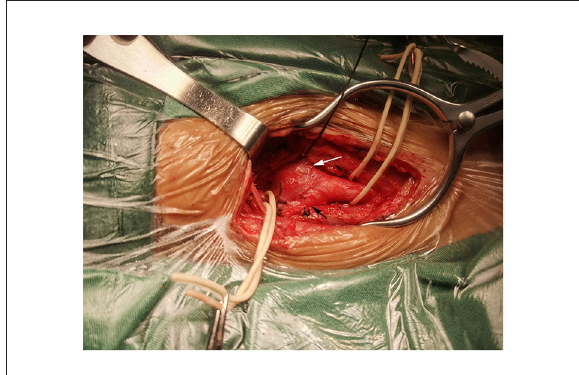
FIGURE2 Intraoperation view of right carotid body tumor resection. A mass at the bifurcation splayed the internal carotid artery (black arrow) and external carotid artery (white arrow).